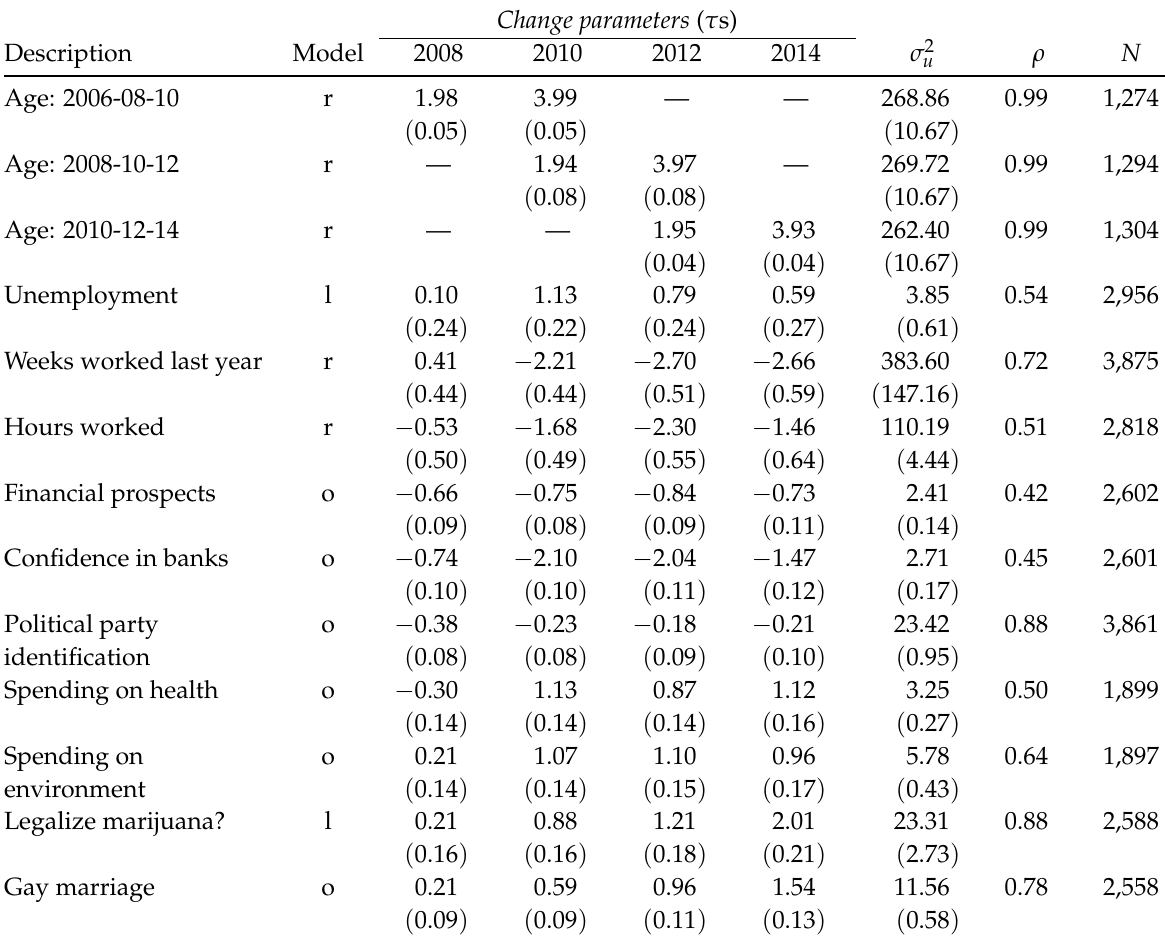
Table 3: Estimates of change parameters ( τ s) from multilevel models for selected GSS variables: 2006–2014. Change parameters ( τ